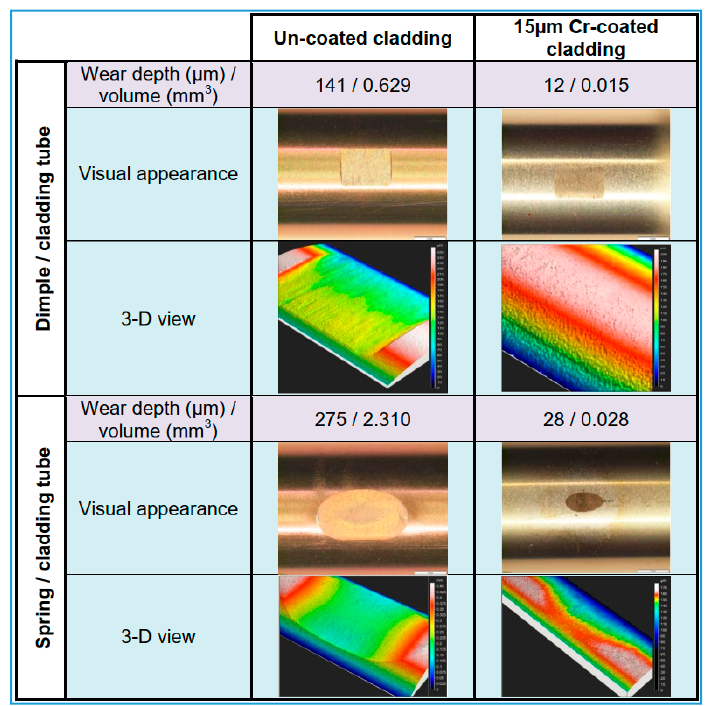
Figure 4. The results of wear test for uncoated and Cr-coated M5 alloys. Reproduced from the work in [19] with copyright permission from the American Nuclear Society (ANS) and the author.